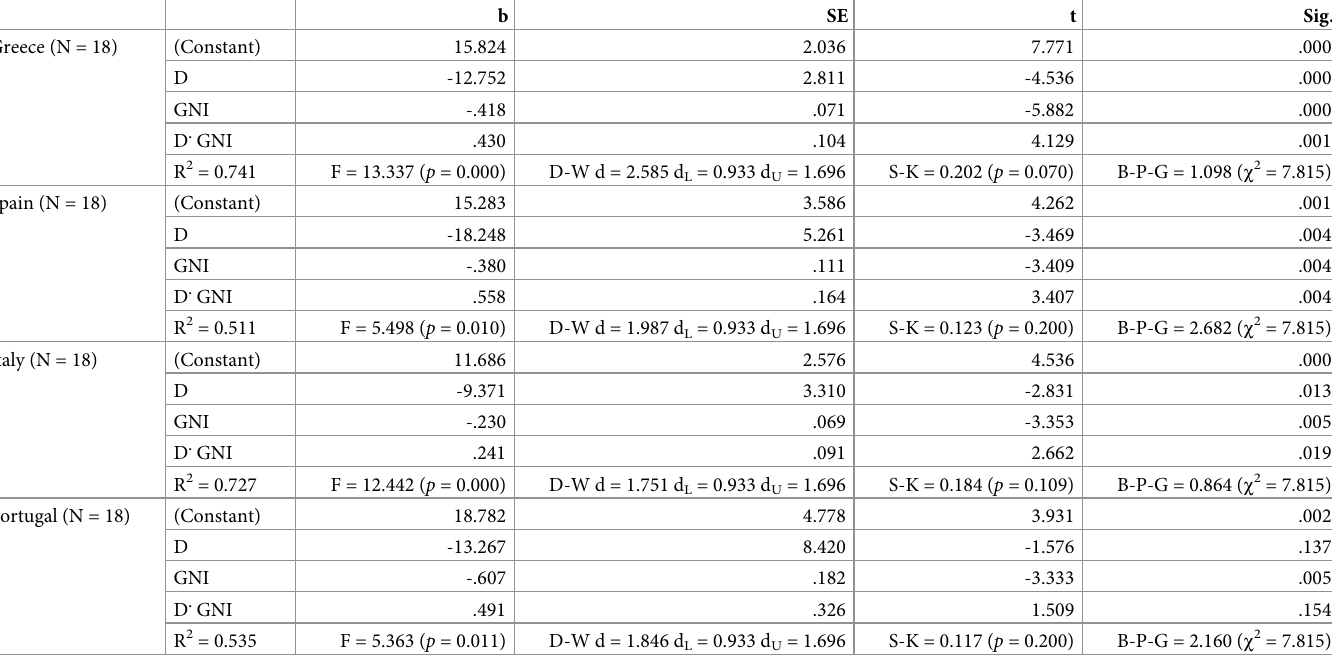
Table 2. Regression results by country: Explanatory variable is Gross National Income (GNI) per capita PPP-adjusted.